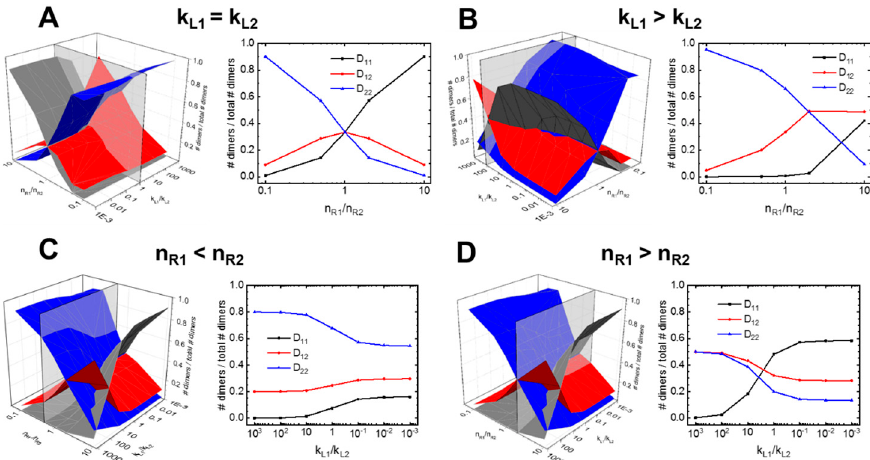
Figure 5. Two-receptor, one-ligand model parameter mapping. Predicted steady-state dimer formation across relative affinity- and concentration parameter spaces, depicting changes in fraction dimer expression: across a range of n R1 concentrations for ( A ) equal receptor binding affinities and ( B ) where L binds n R1 > n R2 ; further, how relative binding rates altered fraction dimer expression where ( C ) n R1 > n R2 and ( D ) when n R1 < n R2 .